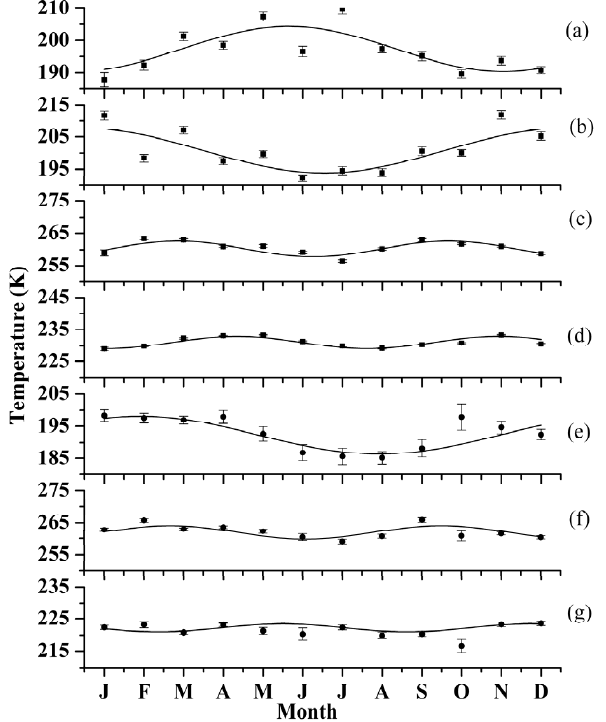
Fig. 4. Folded dataset of monthly mean into one year span with best sinusoidal fit for SABER (a) 90 km, (b) 80 km, (c) 50, (d) 30 km and the same for lidar (e) 80 km, (f) 50 km, (g) 30 km, shown with filled circles. Vertical bars show standard errors. Solid line is the best fit model.